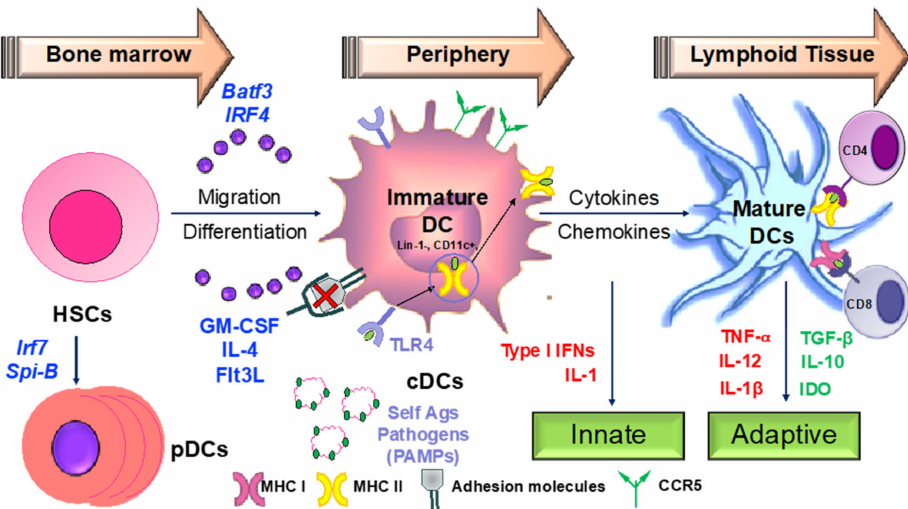
Figure 4. Dendritic cells as sentinels of the immune system. DCs orchestrate the immune response initiating both the innate and adaptive branches of the immune system. Any dysregulation in their activity is the key to development of chronic inflammatory and autoimmune